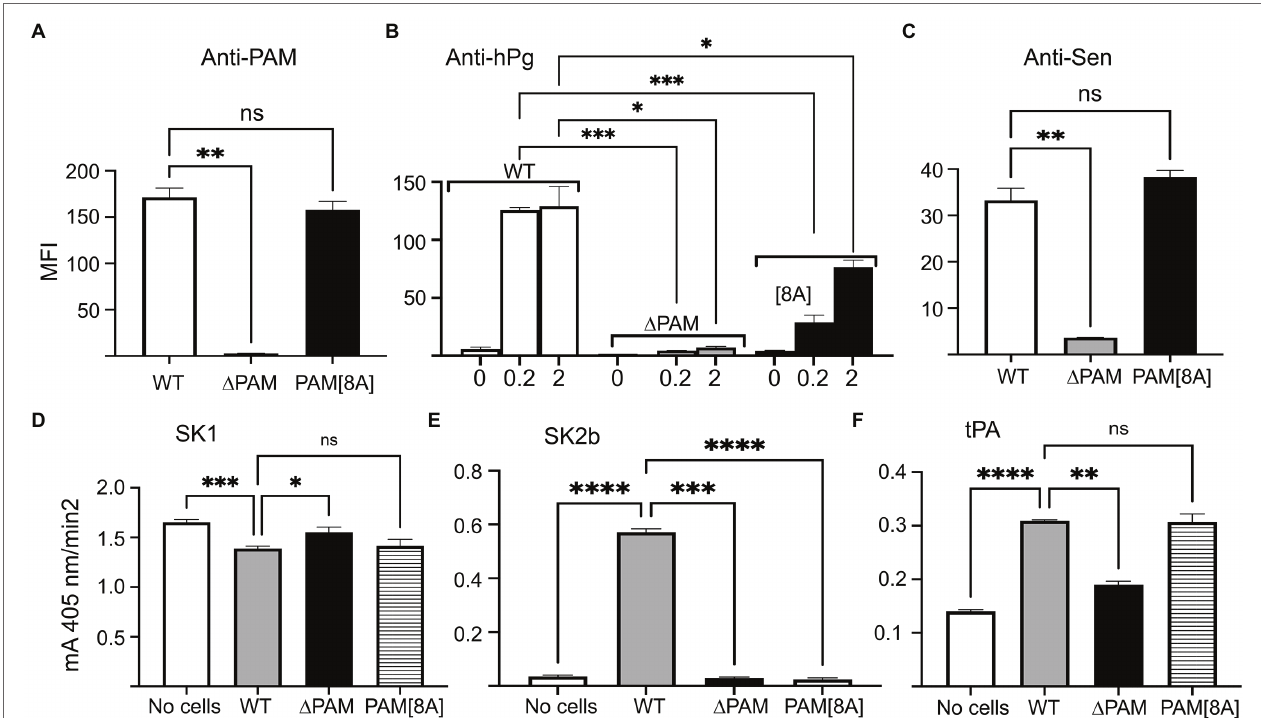
FIGURE 6 | Binding and activation of hPg on whole GAS cells. Mid-log growth phase WT-AP53, AP53/ Δ pam , and AP53/ pam[8A] cells were incubated with: (A) polyclonal rabbit-anti PAM; (B) monoclonal mouse-anti hPg after addition of 200 nM hPg to the cells, and (C) polyclonal rabbit-anti Sen. After this, Alexa Fluor 488-chicken-anti-rabbit IgG was added to cells in (A,C) and Alexa Fluor 488-donkey-anti-mouse IgG for cells of (B) . The fluorescence intensity data were acquired by FACS and reported in bar graph format as the median fluorescence intensity (MFI) of the respective isogenic strains. (D–F) Effect of GAS cells on hPg activation by plasminogen activators. The indicated isogenic mid-log phase AP53 cells (CFU ~ 2 × 10 8 ) were blocked with PBS/1%BSA and 50 μ l of each cell suspension was added to individual wells of 96-well non-protein binding microtiter plates, after which hPg was added to a final concentration of 200 nM. hPg activation was initiated by the addition of 5 nM of (D) SK1, (E) SK2b, or (F) tPA admixed with S2251 (0.25 mM). The release of p-nitroaniline (A 405nm ) from the chromogenic substrate was continuously monitored for 120 min. The initial rates of activation were calculated from the linear regions of A 405nm vs. time plots and shown as the mA 405nm /min 2 . The statistical analyses of data for WT-AP53 cells compared with those of AP53/ Δ pam cells and AP53/PAM[8A] provided probability ( p ) values as indicated by asterisk(s). * p < 0.05; ** p < 0.01; *** p < 0.001; **** p < 0.0001; ns, not